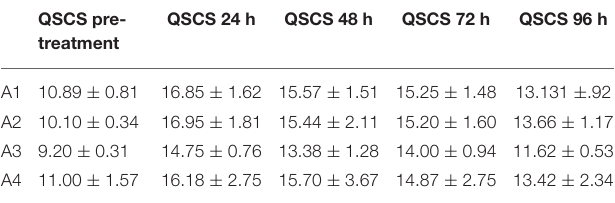
TABLE 6 | Mean ± SD of the quarter mean somatic cell score (QSCS) ( n = 8 per groups A1, A2, and A3 and n = 7 per group A4), before and after administering treatments. Somatic cell count (SCC) of each quarter selected for safety assessment of intramammary formulations, logarithmically transformed into SCS before and every 24h after a single